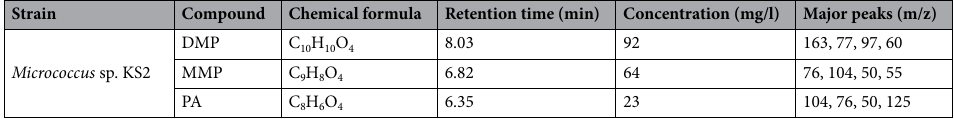
Table 2. Characterization of DMP degradation intermediates [DB-5 column (30 m × 0.25 mm × 0.25 m) with helium as carrier gas at a flow rate of 1.0 mL min −1 ; Inlet temperature 300 °C; split ratio of 20:1].